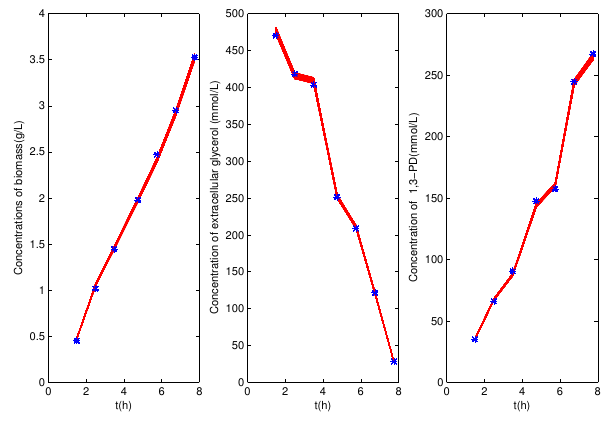
Figure 4. Comparison of biomass, glycerol, 1,3-PD concentration between experimental data and computational results x ( t,x 4